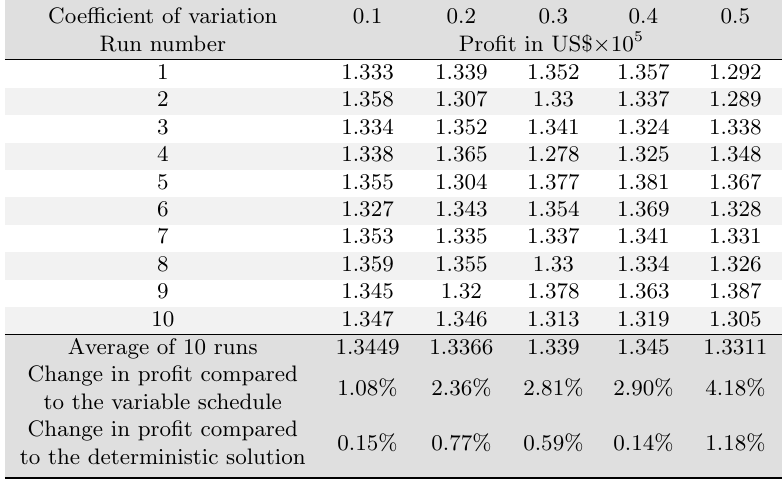
Table 13: Profit from fixed schedule and random catch of IFPML ( t ) .